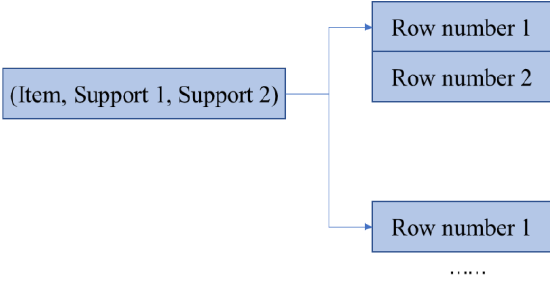
Figure 9. Struct node of data structure diagram.